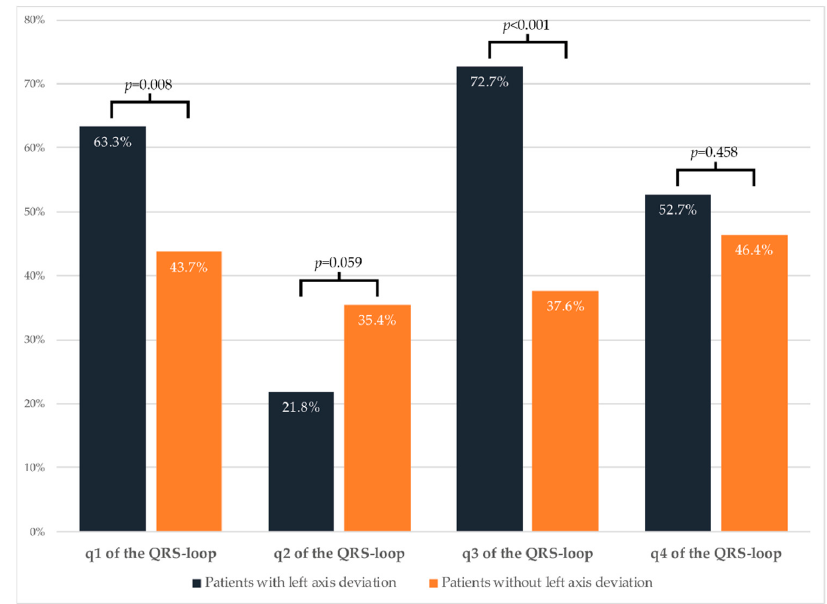
Figure 3. Proportion of patients with conduction slowing above the median value of the entire cohort.